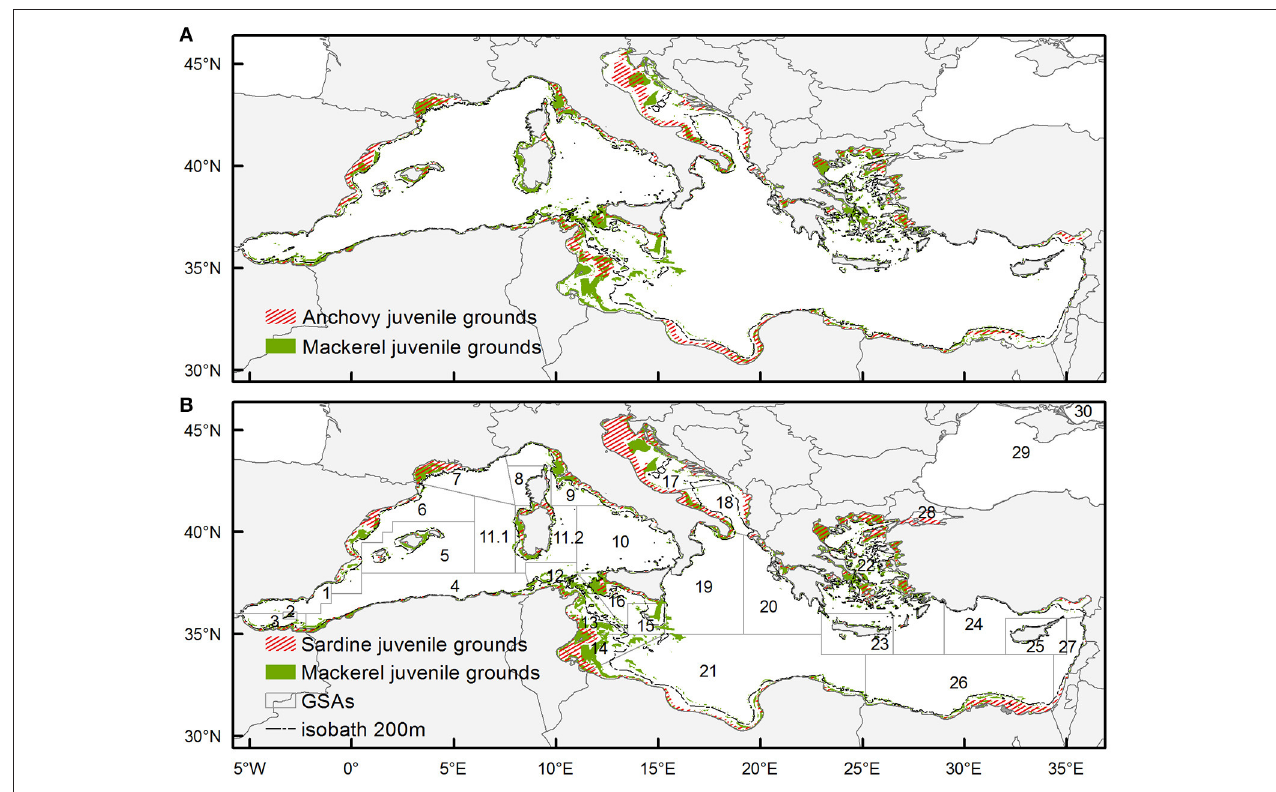
FIGURE 4 | Overlapping of mackerel juveniles’ occasional and persistent habitat with (A) anchovy juveniles’ occasional and persistent habitat and (B) sardine juveniles occasional and persistent habitat. Anchovy juveniles’ habitat is redrawn based on Giannoulaki et al. (2013). Sardine juveniles’ habitat is redrawn based on Giannoulaki et al. (2011). GFCM Geographical Subareas (GSAs) (http://www.fao.org/gfcm/data/map-geographical-subareas/en/) are